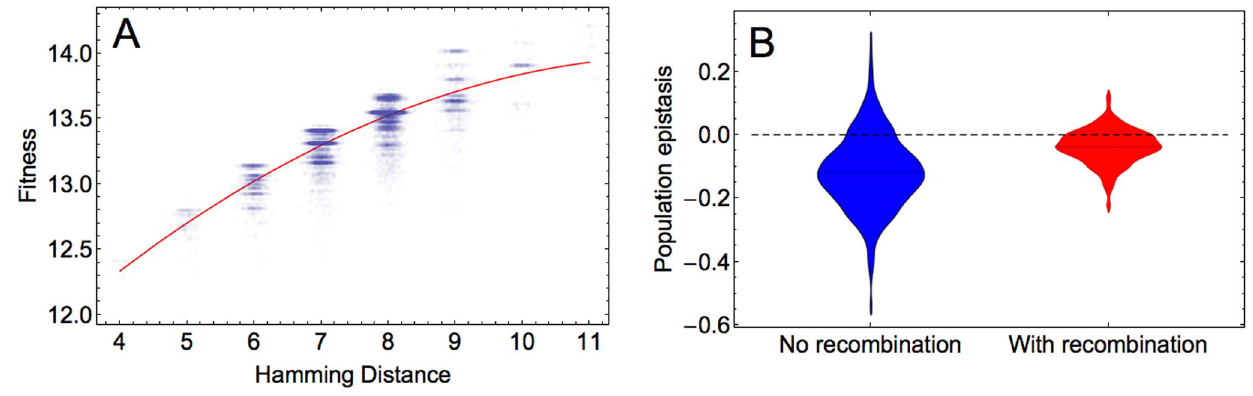
Figure 4. Population epistasis of the HIV-1 fitness landscape. A) An example of the log fitness plot against the Hamming distance between the reference sequence and sequences at generation 100 of one simulation for 20000 data points. Each point corresponds to one fitness value. To improve the visualization of the data on x axis, random values taken from a normal distribution with mean 0 and standard deviation 0.1 are added to the Hamming distances. The curvature of the red curved fitted to the data points defines population epistasis, which in this example is 2 0.0405. B) Distribution of population epistasis values across 500 simulations in the absence (blue) and presence (red) of recombination measured at generation 100. Parameters take values: N ~ 10 5 , r ~ 10 { 1 and u ~ 10 { 3